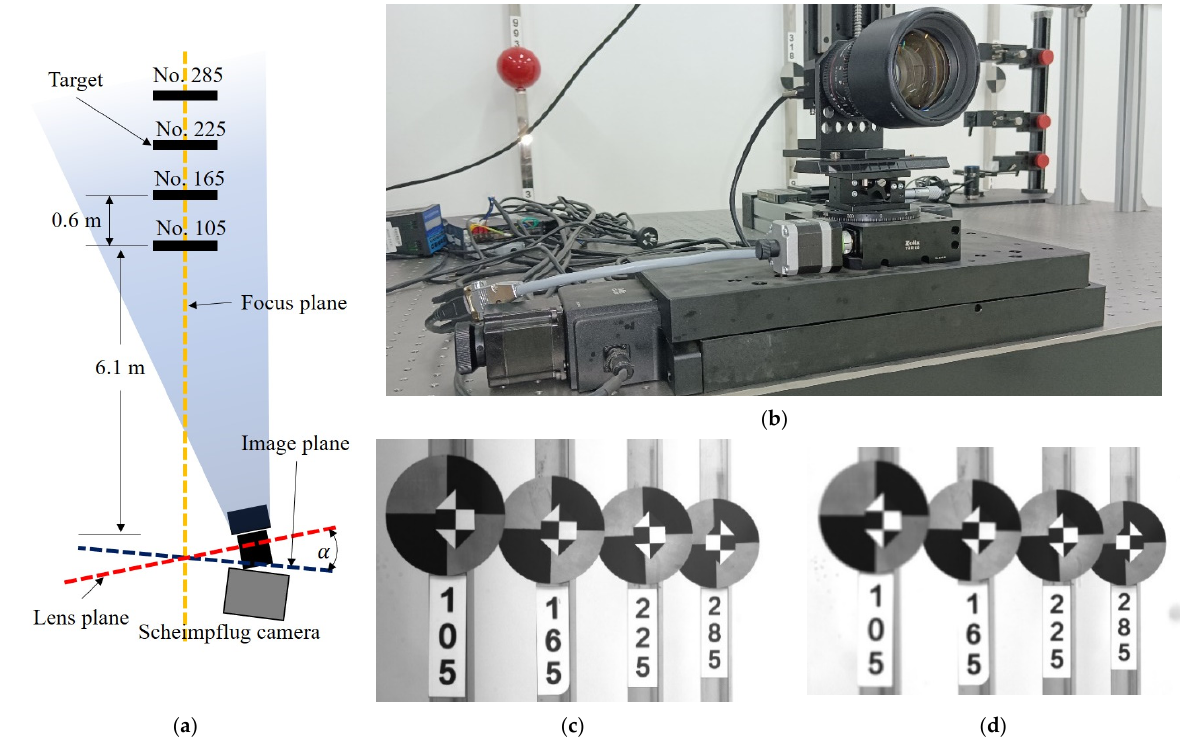
Figure 9. Experiment setup and target selection. ( a ) Experiment setup, where blue shade represents FOV. ( b ) Scheimpflug camera. ( c ) The imaging result of the Scheimpflug camera. ( d ) The imaging result of the conventional camera.